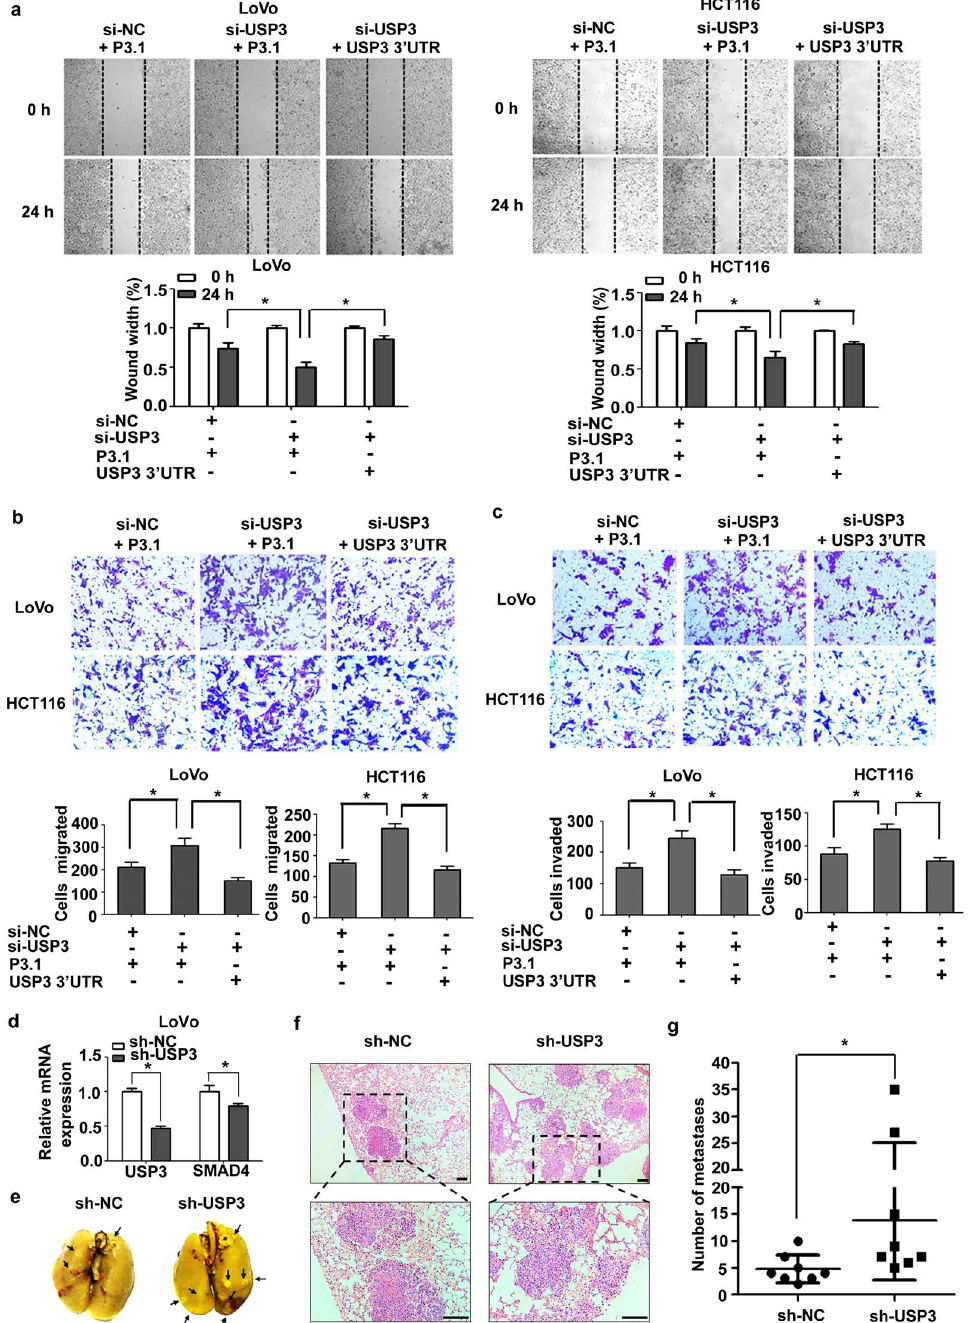
Figure 4. Reduced USP3 expression promoted migration and invasion of CRC cells in vitro and in vivo . ( a ) Wound-healing assays were performed to detect CRC cell migration after transfection with si-USP3 or co- transfection with si-USP3 and USP3 3 ′ UTR. Photographs were obtained 0 and 24 h after scratching. ( b,c ) Transwell assays with or without Matrigel coatings were used to evaluate migration and invasion by LoVo and HCT116 cells after the indicated transfection treatment. The migratory or invasive cells were stained with crystal violet, and counted under a microscope in five random fields at 100 × magnification. Quantification data are shown as the mean ± SD (n = 3). * P < 0.05. ( d ) After transduction of the sh-USP3 lentivirus, mRNA expression of USP3 and SMAD4 were both reduced in LoVo cells compared with the group transduced with sh-NC lentivirus. ( e ) Representative photographs of lungs stained with picric acid, which were harvested from NOD/SCID mice eight weeks after injection with stably transduced sh-NC or sh-USP3 LoVo cells (2 × 10 6 cells per injection) via tail veins (n = 8); arrows indicate metastatic tumours. ( f ) Representative images of haematoxylin and eosin-stained sections in sh-NC and sh-USP3 lung metastatic foci. Scale bars, 100 μ m. ( g ) The number of lung metastatic nodules was counted under a microscope. The results are presented as the mean ± SD (n = 8), * P <